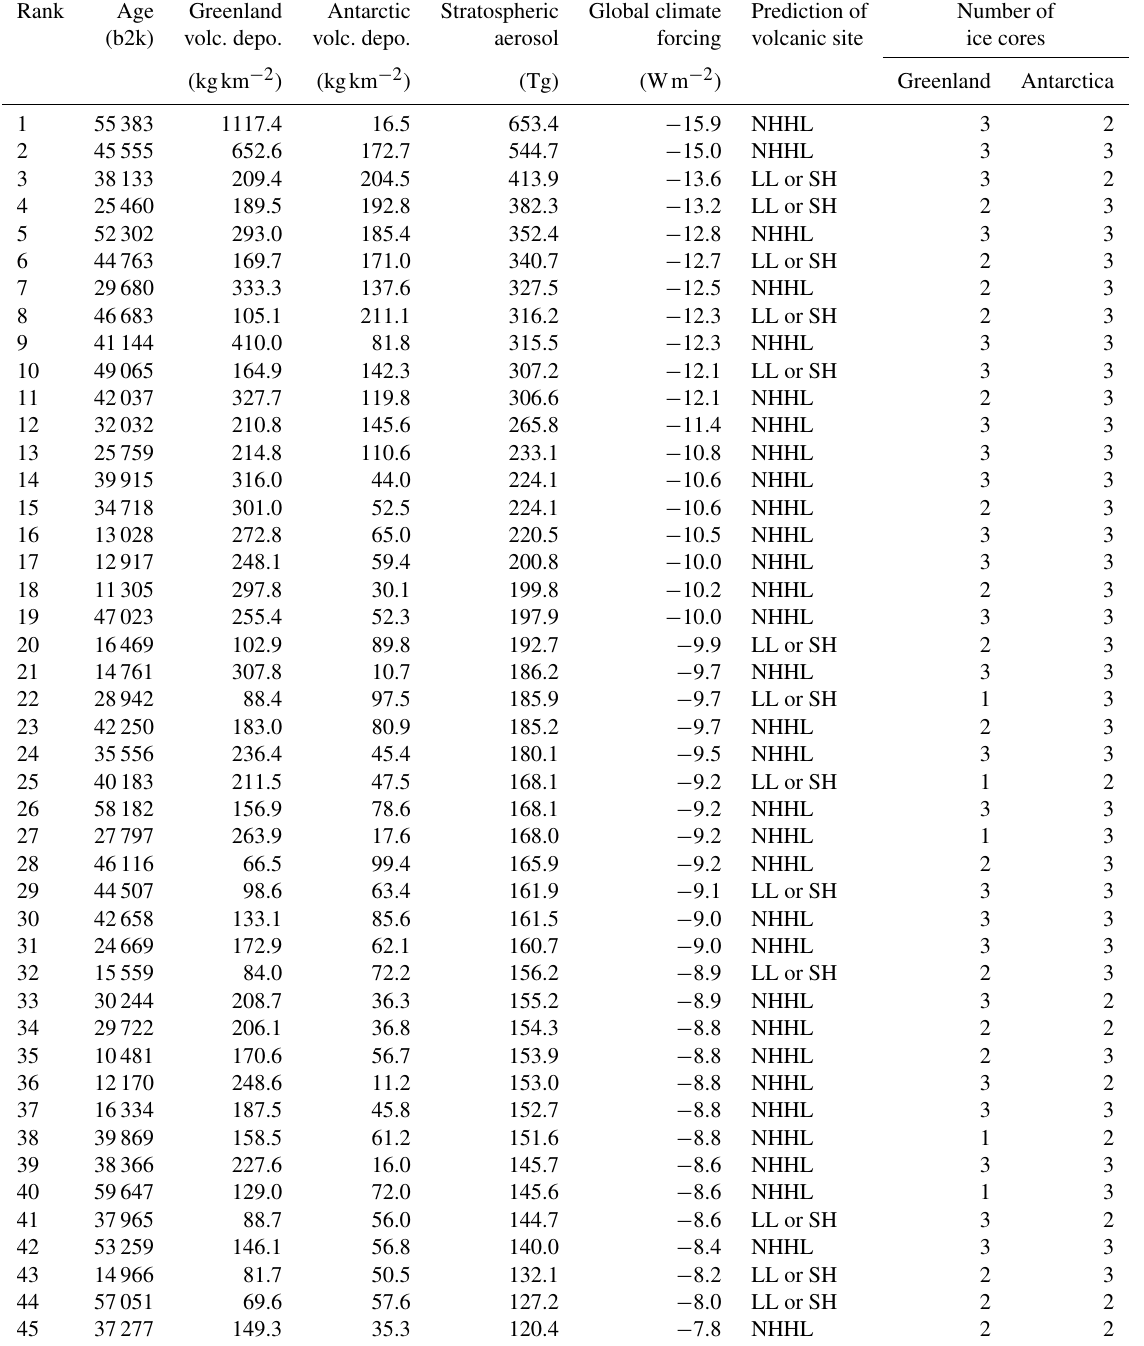
Table 2. The largest bipolar volcanic eruptions of the last glacial period and early Holocene ranked by the volcanic aerosol forcing that is derived from the average Greenland and Antarctic volcanic sulfate depositions. The stratospheric aerosol loading was estimated according to Gao et al. (2007), and the radiative volcanic aerosol forcing was reconstructed with a scaling factor of SAOD obtained from Aubry et al. (2020) and a scaling factor to obtain the radiative forcing following Marshall et al. (2020) (Sect. 4.3). “NHHL” refers to high-latitude Northern Hemisphere locations of volcanoes, meaning above 40 ◦ N; “LL or SH” refers to low-latitude or Southern Hemisphere locations, meaning below 40 ◦ N. “Number of ice cores” refers to the number of ice cores in Greenland and Antarctica in which the volcanic sulfate signal has been